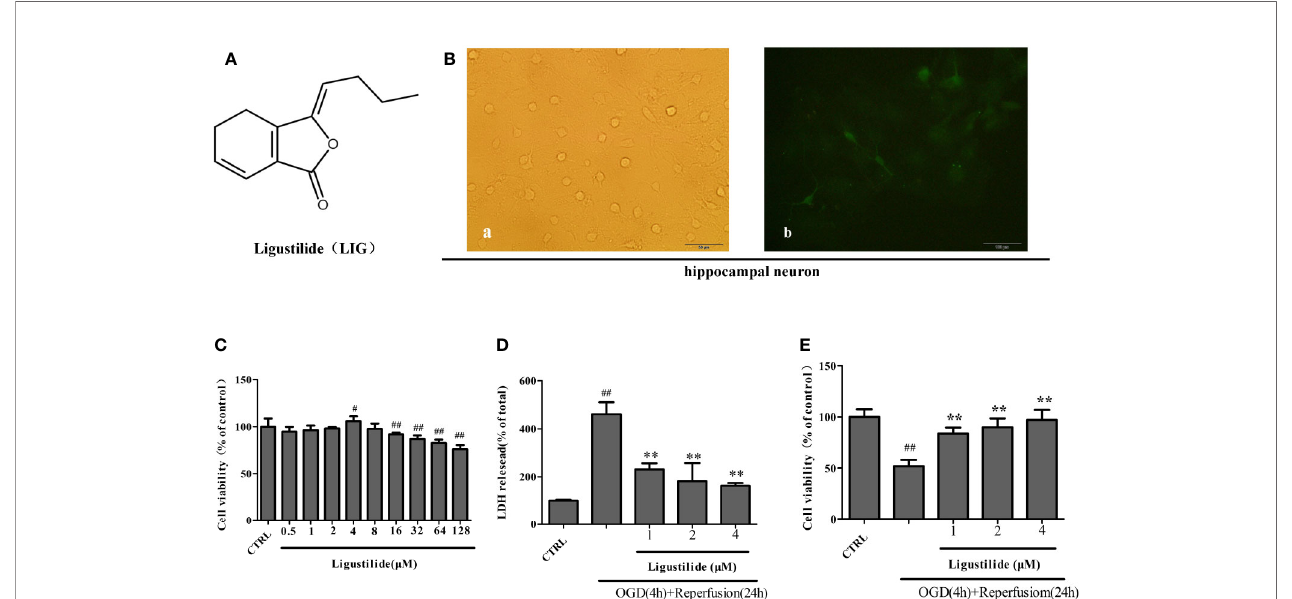
FIGURE 1 | Ligustilide (LIG) promotes viability of hippocampal neurons induced by oxygen-glucose deprivation/reperfusion (OGD/R). (A) Chemical structure of LIG. B.Primary culture and identi fi cation of hippocampal neurons. (B-a) The seventh day of primary culture of hippocampal neuron by light microscope. (B-b) Hippocampal neuron were identi fi ed by MAP-2 immunostaining. (C) Hippocampal neurons were treated with LIG at various concentrations(0.5 – 128 m M) and the cell viability was measured by the MTT assay. (D) Effect of ligustilide on the release of LDH from hippocampal neurons damaged by OGD/R. (E) Cell viability was measured by the MTT assay after OGD/R and normal conditions. All data are expressed as means ± SD (n = 8). ## P < 0.01 vs. control group; ** P < 0.01 vs. group treated with